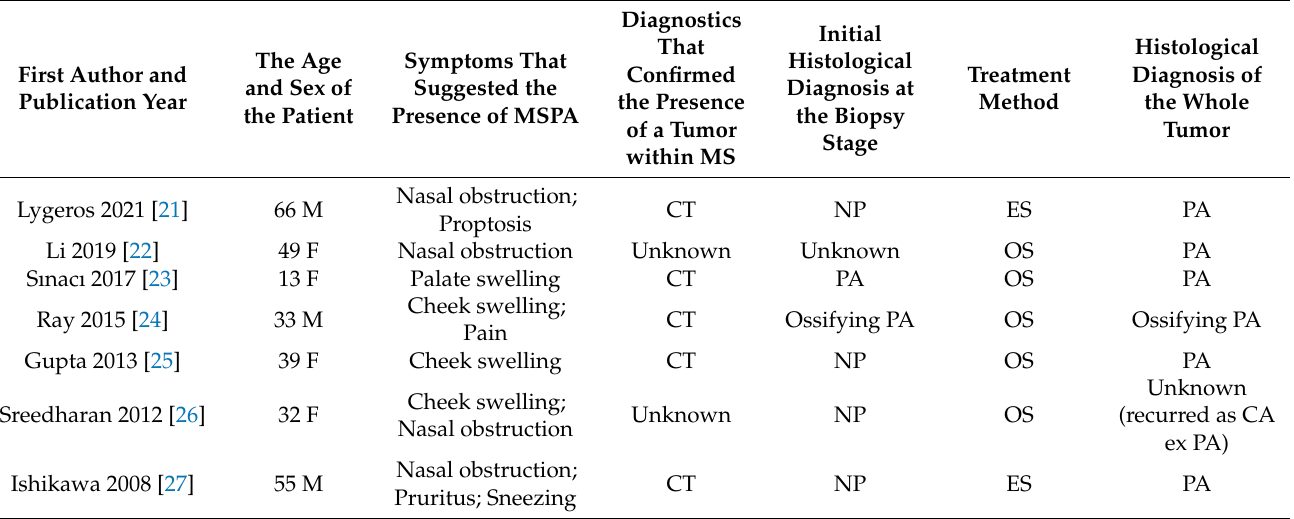
Table 6. Included studies. NP—Not performed; F—female; M—male; PA—Pleomorphic adenoma;